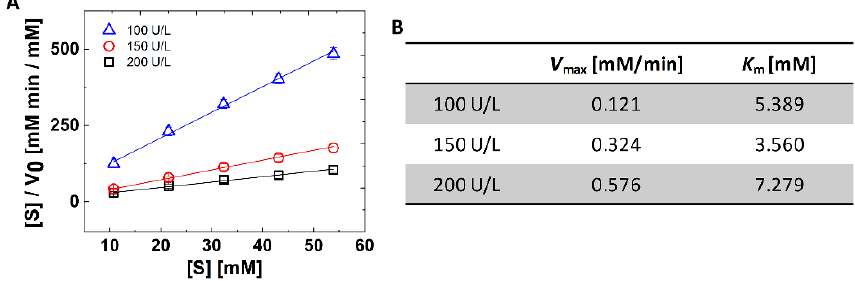
Figure 5. The results of the enzyme kinetics study. ( A ) The Hanes–Woolf plot for the various concentrations of ALP. The error bars represent the standard deviation of three replicates of the assay. ( B ) V max and K m value of each enzyme unit were obtained from the linear fitting of panel A.